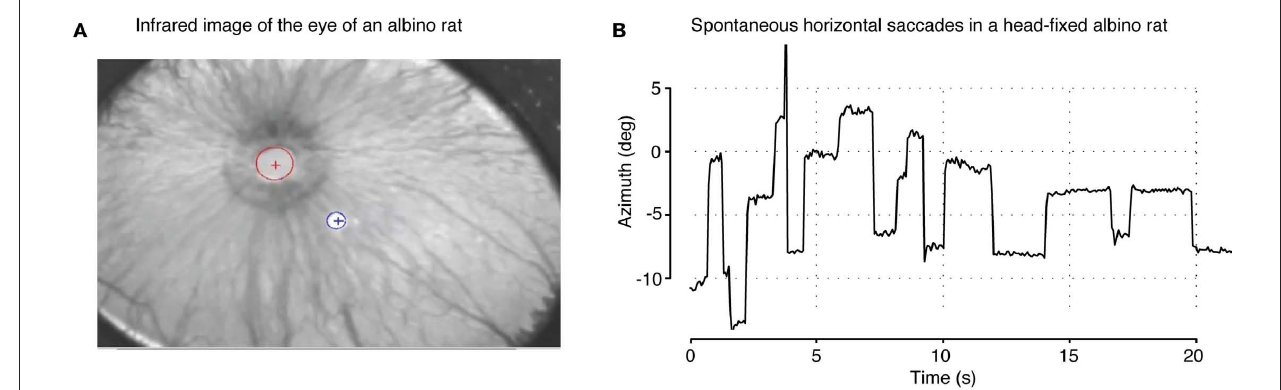
to a more reflective unpigmented retinal epithelium and significant illumination through the unpigmented iris. The red and blue circle/cross indicates, respectively, the position of the pupil and corneal reflection spot. (B) Examples of spontaneous saccades measured in an albino rat (comparable to Figure 8 A